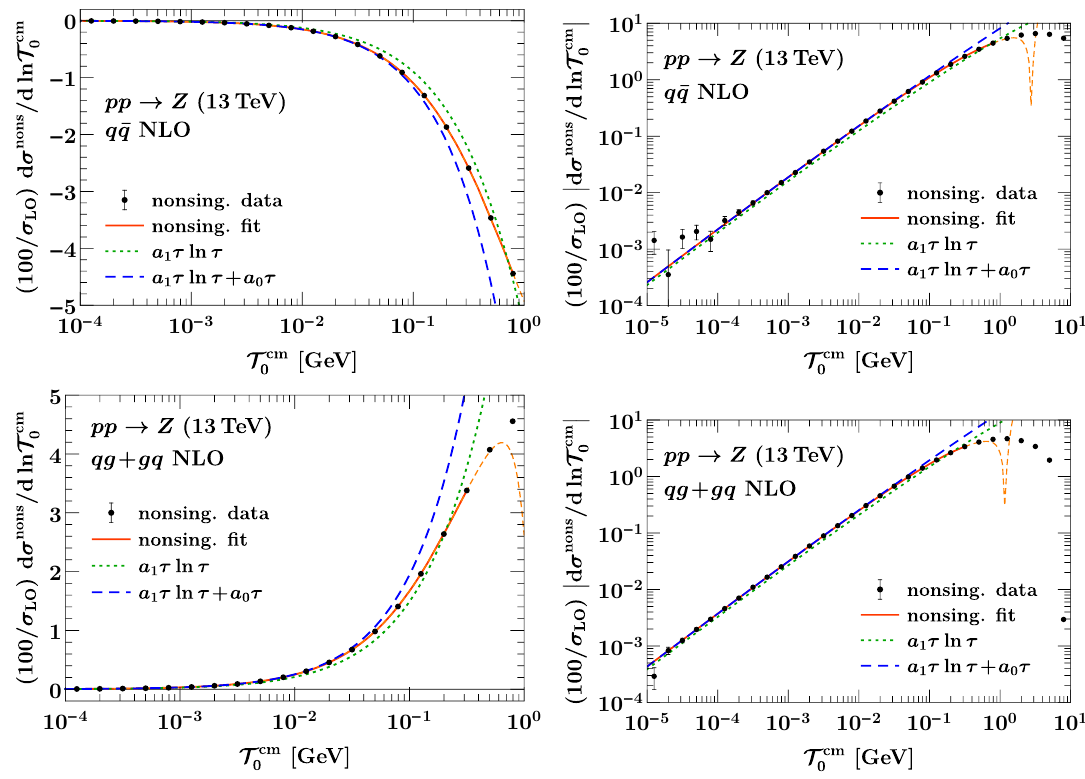
Figure 4 . Same as (cid:12)gure 2 for the hadronic T